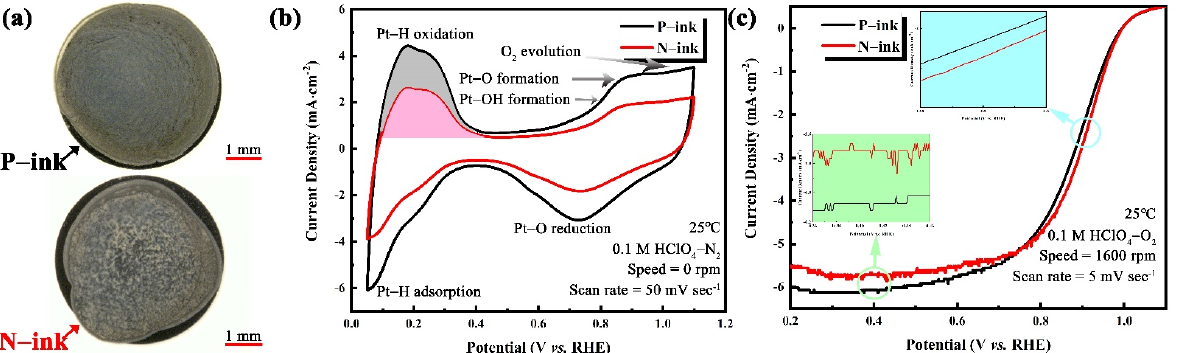
Figure 8. ( a ) Optical photograph and ORR performance of the electrodes in an RDE: ( b ) CV and ( c ) the corresponding ORR polarization curves.